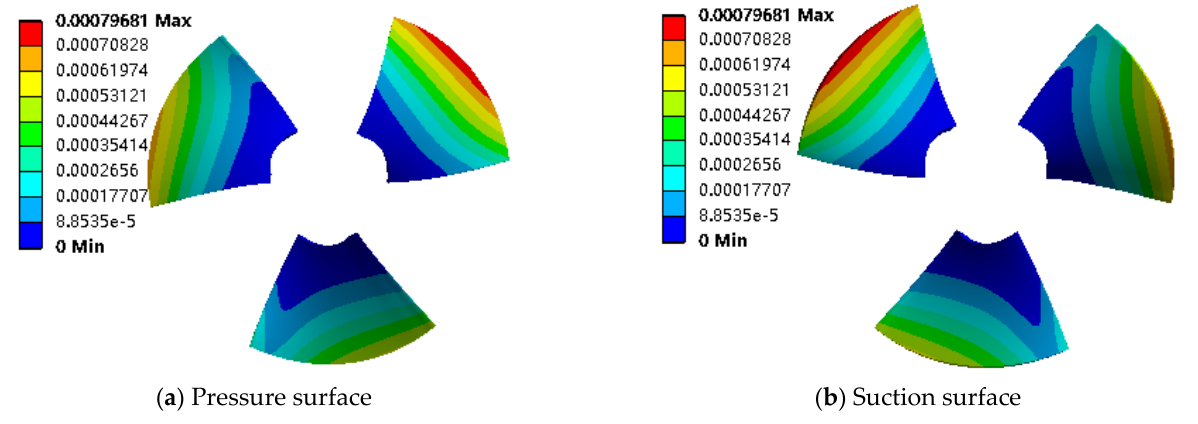
Figure 19. Q = 28 m 3 /s Deformation of impeller, Unit: m.